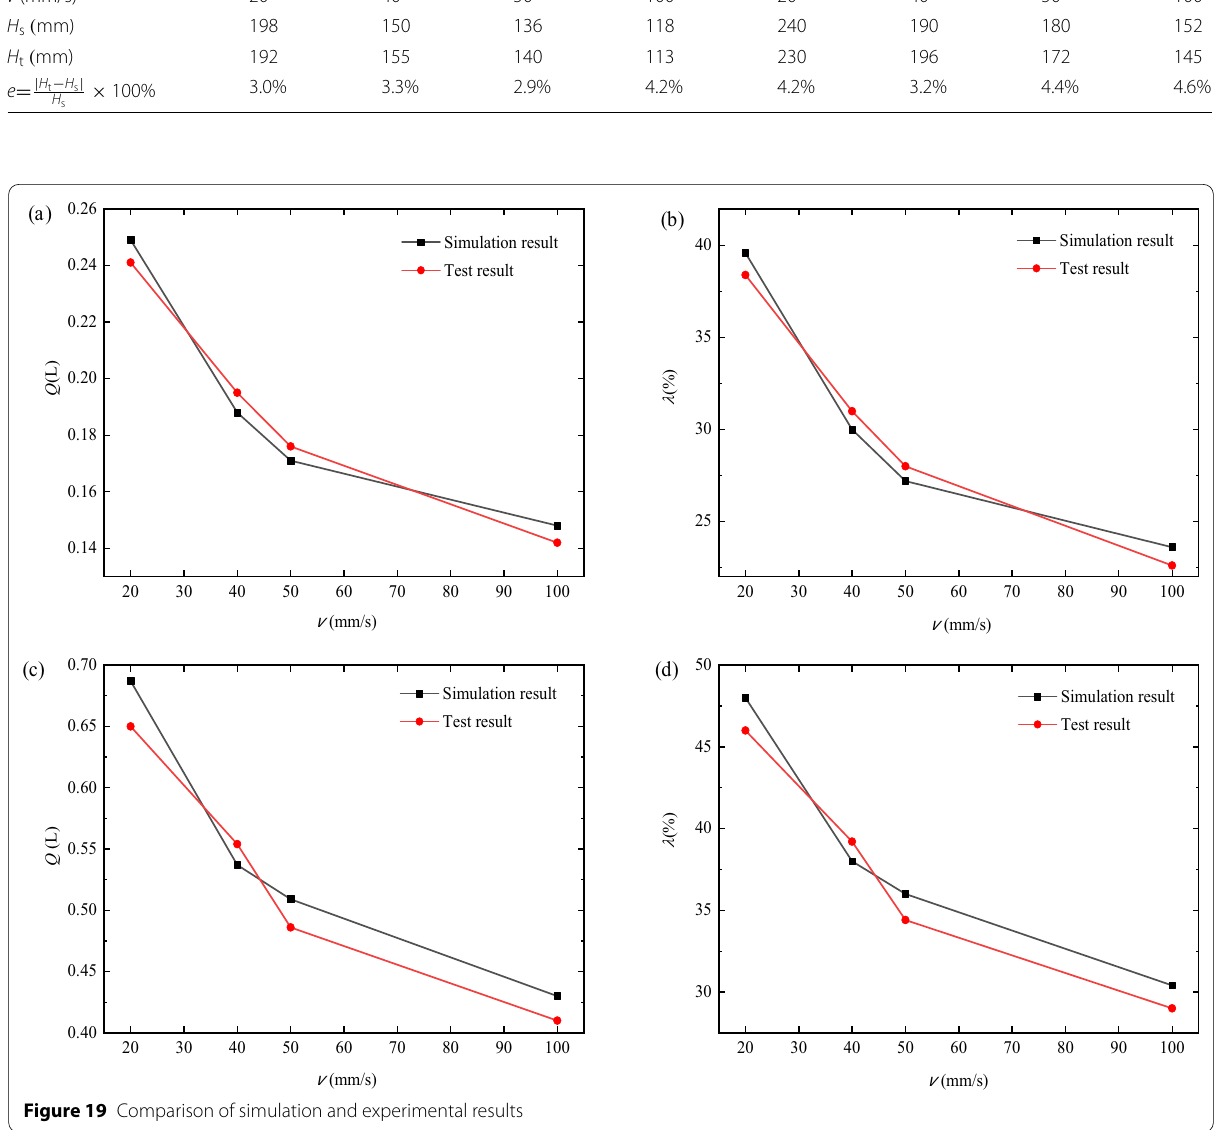
Figure 19 Comparison of simulation and experimental